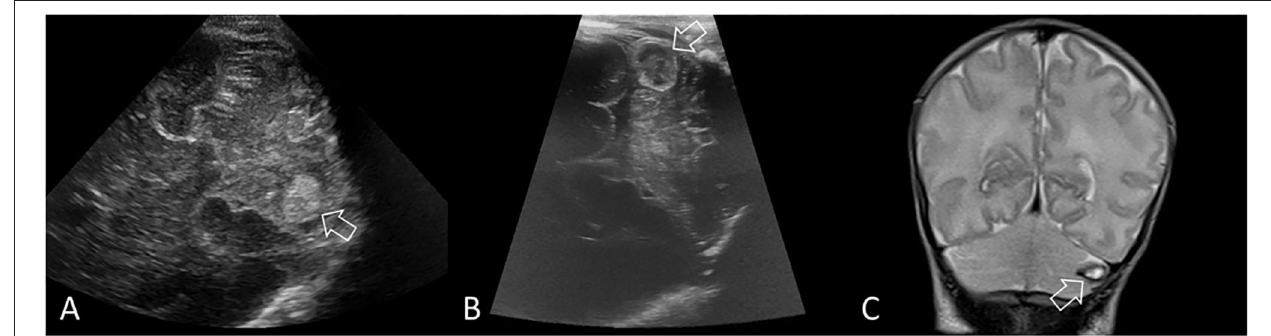
FIGURE 6 | Limited cerebellar hemorrhage. Ultrasound scan in a preterm infant (GA 29 weeks) with a limited CBH ( > 4mm but < 1/3 of the cerebellar hemisphere). (A) Coronal scan through the right mastoid fontanel 5 days after birth shows a rounded echogenic lesion in the left cerebellar hemisphere (arrow), indicating intraparenchymal hemorrhage. The fourth ventricle is borderline dilated (not shown). (B) Repeat coronal scan through the left mastoid fontanel at 2 weeks after birth shows expected evolution of the hemorrhage (arrow), which is becoming echolucent, indicating early cystic degeneration. (C) Coronal T2-weighted MRI at 6 weeks after birth shows continued evolution of the hemorrhage with smaller cystic cavity that displays uniform central T2 hyperintense signal and thin hypointense rim (arrow, hemosiderin and ferritin). Surrounding cerebellar edema has resolved with local destruction and atrophy of that hemisphere. The appearance of high intensity on T1-weighted (not shown) and T2-weighted inside the hemosiderin rim stages the hemorrhage to the late subacute phase (extracellular